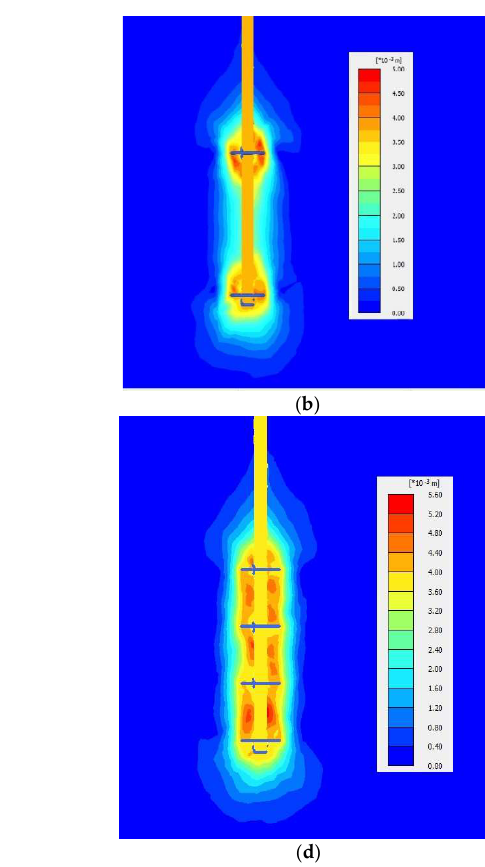
1.06 Figure 14. Capacity ratio vs. Embedment depth ratio. 0.940.960.981 1.02 1.04